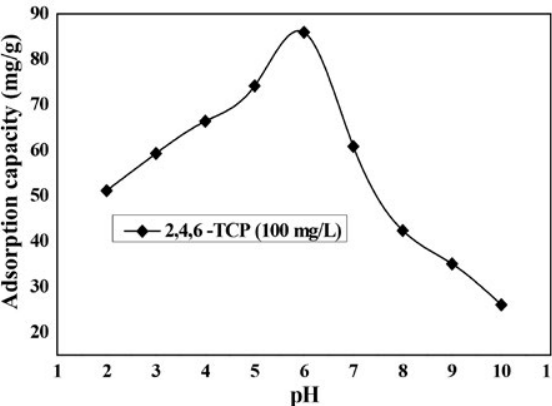
Figure 4 . Influence of adsorbent dosage on the 2,4,6- trichlorophenol biosorption onto PBP [Removal (%) and biosorption capacity (mg/g)]. Experimental conditions: Temp = 25 ± 1 °C biosorbent dosage = 0.05– 0.8g, initial concentrations = 100 mg/L, pH 6.0, contact time